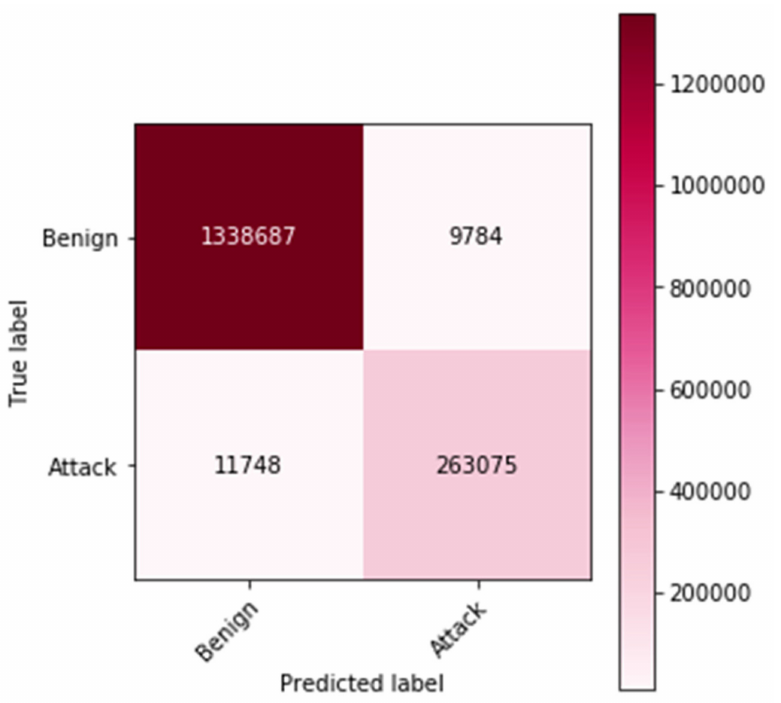
Figure 10. Confusion matrix without